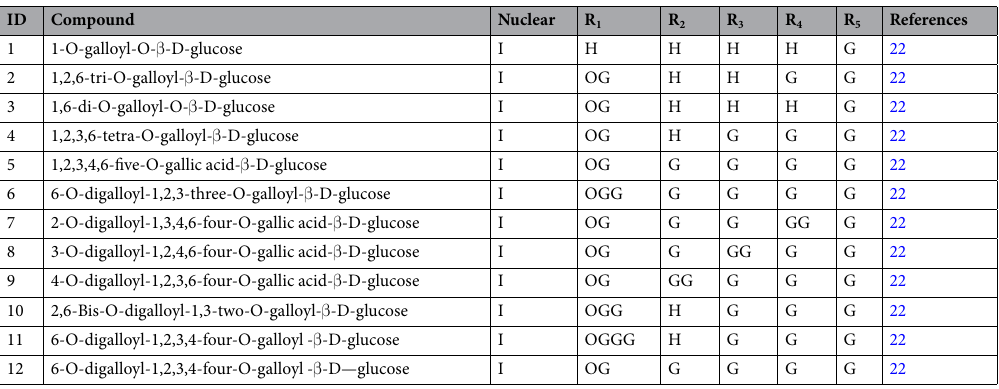
Table 1. Type I Turkish galls compounds.